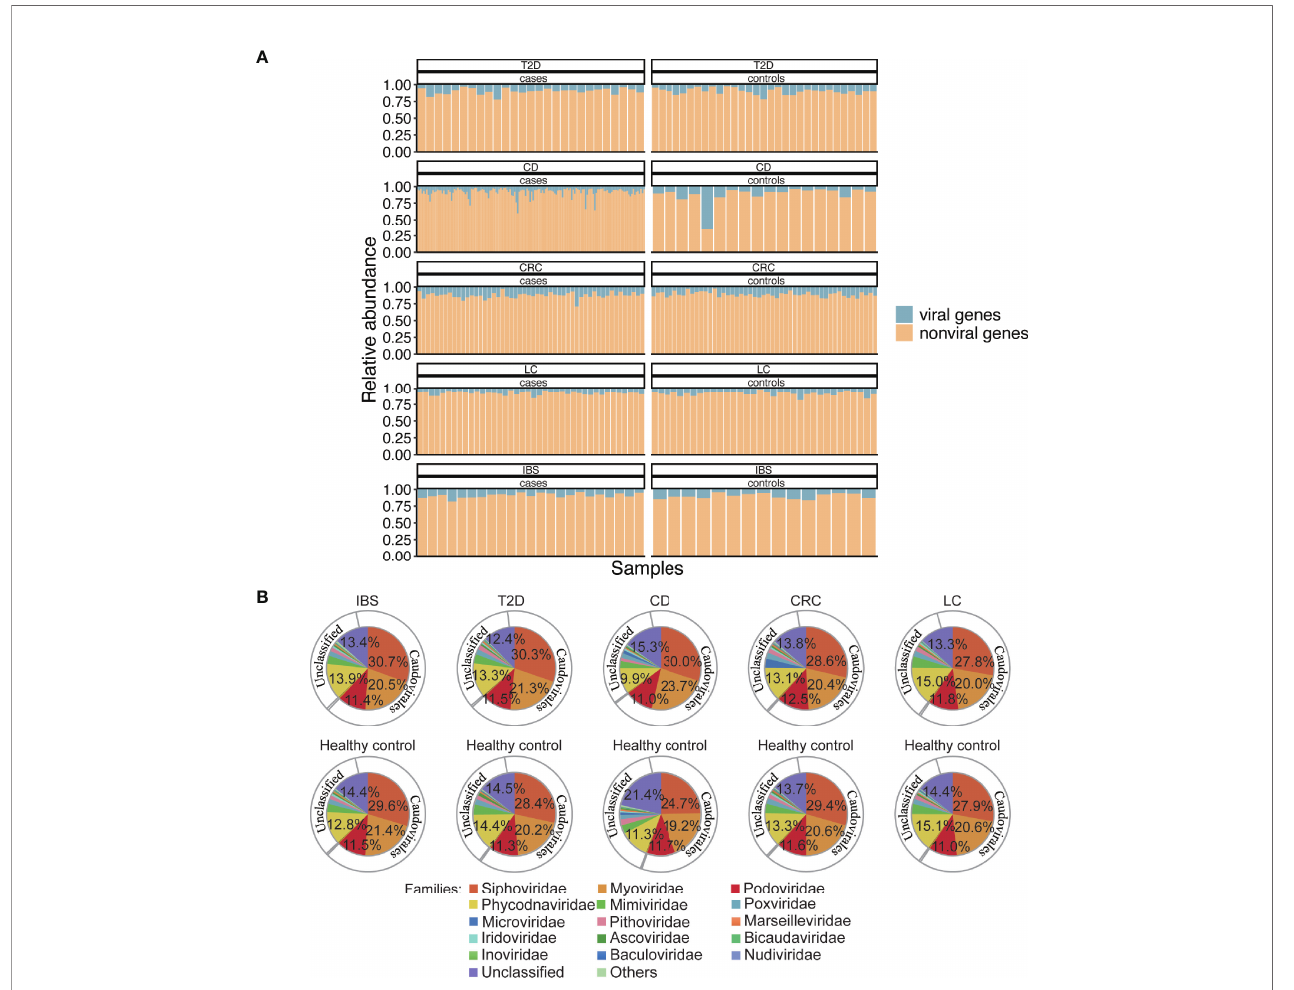
FIGURE 3 | Abundance and composition of the gut virome in different groups. (A) Viral gene abundance in different samples. The blue part of each bar is the viral gene abundance relative to all the predicted genes in that sample and represents the portion of reads from the detected viral genes to reads from all genes in a sample. (B) Composition of viruses in family and order level. Inner pie chart, viral families. Outer circle, corresponding orders to the families. Microviridae , Inoviridae , Bicaudaviridae , and families that belong to Caudovirales are bacteriophages. Phycodnaviridae , Mimiviridae , Poxviridae , Marseilleviridae , Iridoviridae , and Ascoviridae are Megavirales known as nucleocytoplasmic large DNA viruses (eukaryotic viruses). Pithoviridae , Baculoviridae , and Nudiviridae are also eukaryotic